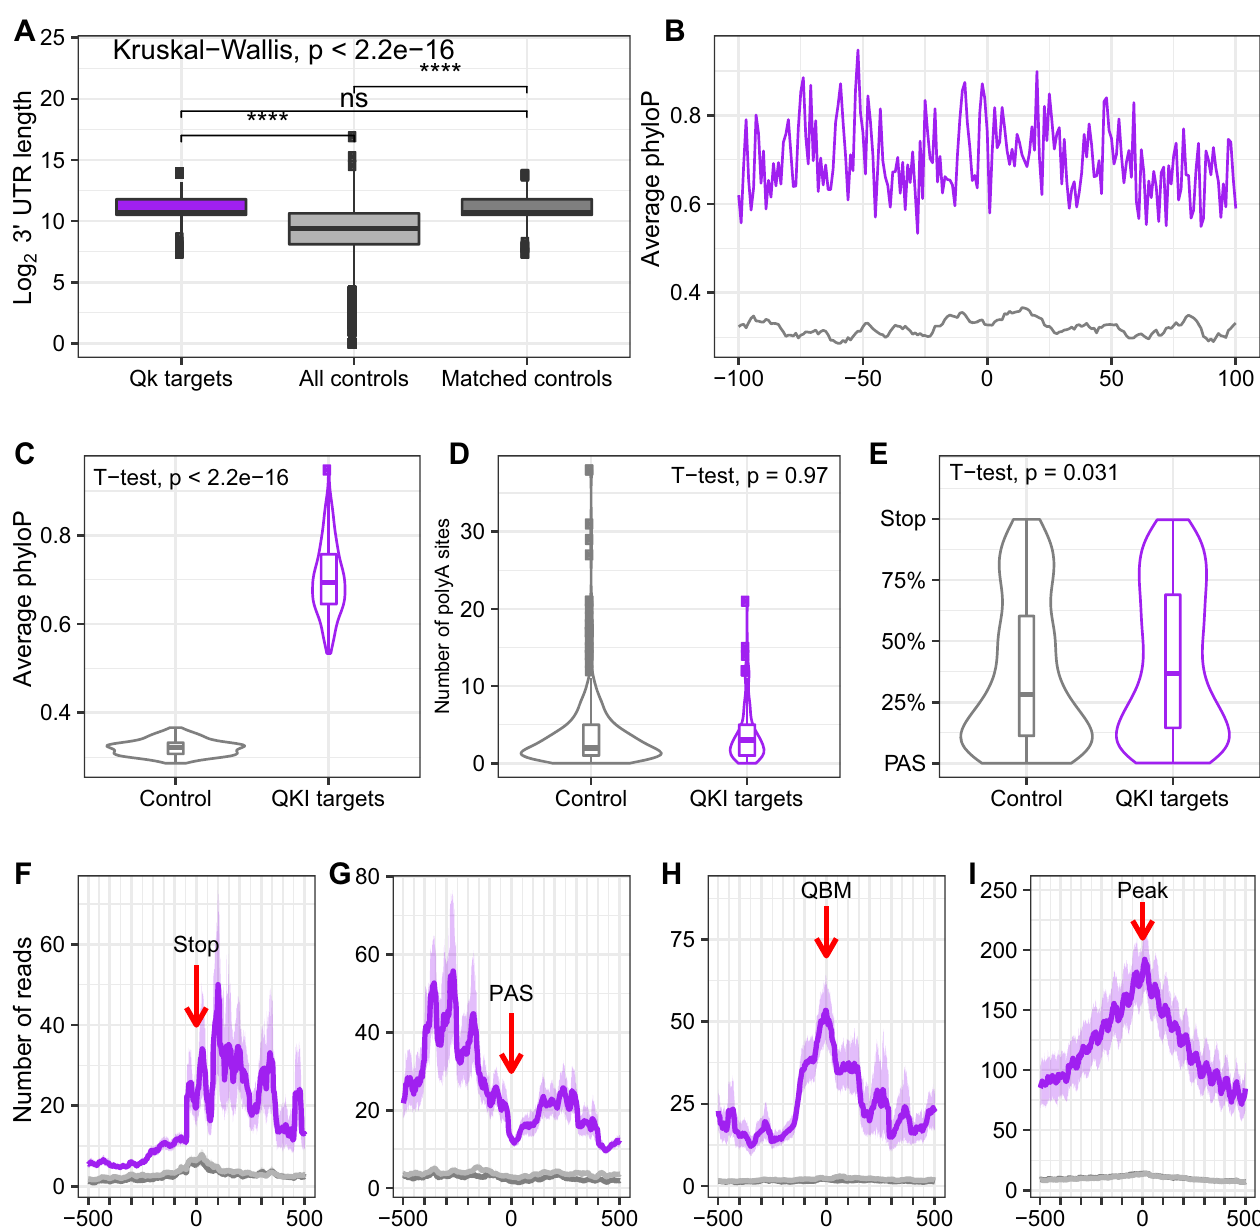
Fig. 2 QKI-6 binds conserved UTR regions in a cooperative manner. A UTRs bound by QKI-6 are signi fi cantly longer than average UTRs. N = 574 Qk targets, n = 39,337 all controls, and n = 574 matched-length controls. Rightmost plot: matched-length controls selected for B – G . The signi fi cant levels represent Mann – Whitney test by comparing to UTRs bound by QKI-6. The p values of comparing all controls UTRs to QKI-6 bounded UTRs, matched- length controls UTRs to QKI-6 bounded UTRs, and matched-length controls UTRs to all controls UTRs are <2.2e − 16, 0.68, and <2.2e − 16, respectively. B Conservation levels (PhyloP) of 200 bp fl anking QKI-6 bound sites reveal QKI-6 bound sites are more conserved than random sites in matched-length controls. C A violin plot illustration of the same data showing the distribution of conservation across all targets ( p value < 2.2e − 16). N = 200 bp fl anking QKI-6 bound sites and n = 200 bp fl anking random sites in matched-length controls. D A violin plot for number of PolyA sites near QKI-6 peaks reveals they are not enriched for PolyA sites ( p value = 0.97). N = 141 unique 3 ’ UTR for Qk targets and n = 547 unique 3 ’ UTR for matched-length controls. E Examining the QKI peak location relative to the length of the UTRs (scaled to 100% of distance between PAS and stop codon) shows QKI-6 binding tends to be closer to stop codons ( p value = 0.031). N = 426 3 ’ UTR for Qk targets in which QKI-6 bound sites are between their nearest PAS and stop codon and n = 307 3 ’ UTR for matched-length controls in which random sites are between their nearest PAS and stop codon. F Metagene of QKI-6 shows binding is elevated at stop codon, with fl anking peaks, and extends substantially, especially 3 ’ . G Metagene of QKI-6 shows binding is elevated at PAS, with fl anking peaks, and extends substantially, especially 5 ’ . QKI-6 binding at any ( H ) QBM or ( I ) peak extends to fl anking sequence. Here, and for all box-and-whiskers plots in the manuscript, the center line represents the median, the body of the box goes from the fi rst quartile to the third quartile (IQR), the whiskers represent 1.5x IQR from the upper or lower quartile, and points represent values that go beyond 1.5 IQR. The p values represent two-sided Student ’ s t test. In B – E , p values represent two-sided Student ’ s t tests. In F – I , ribbons represent the 95% con fi dence interval of the mean calculated using 1000 bootstraps. Purple = QKI-6 CLIP, light gray = Input, dark gray =